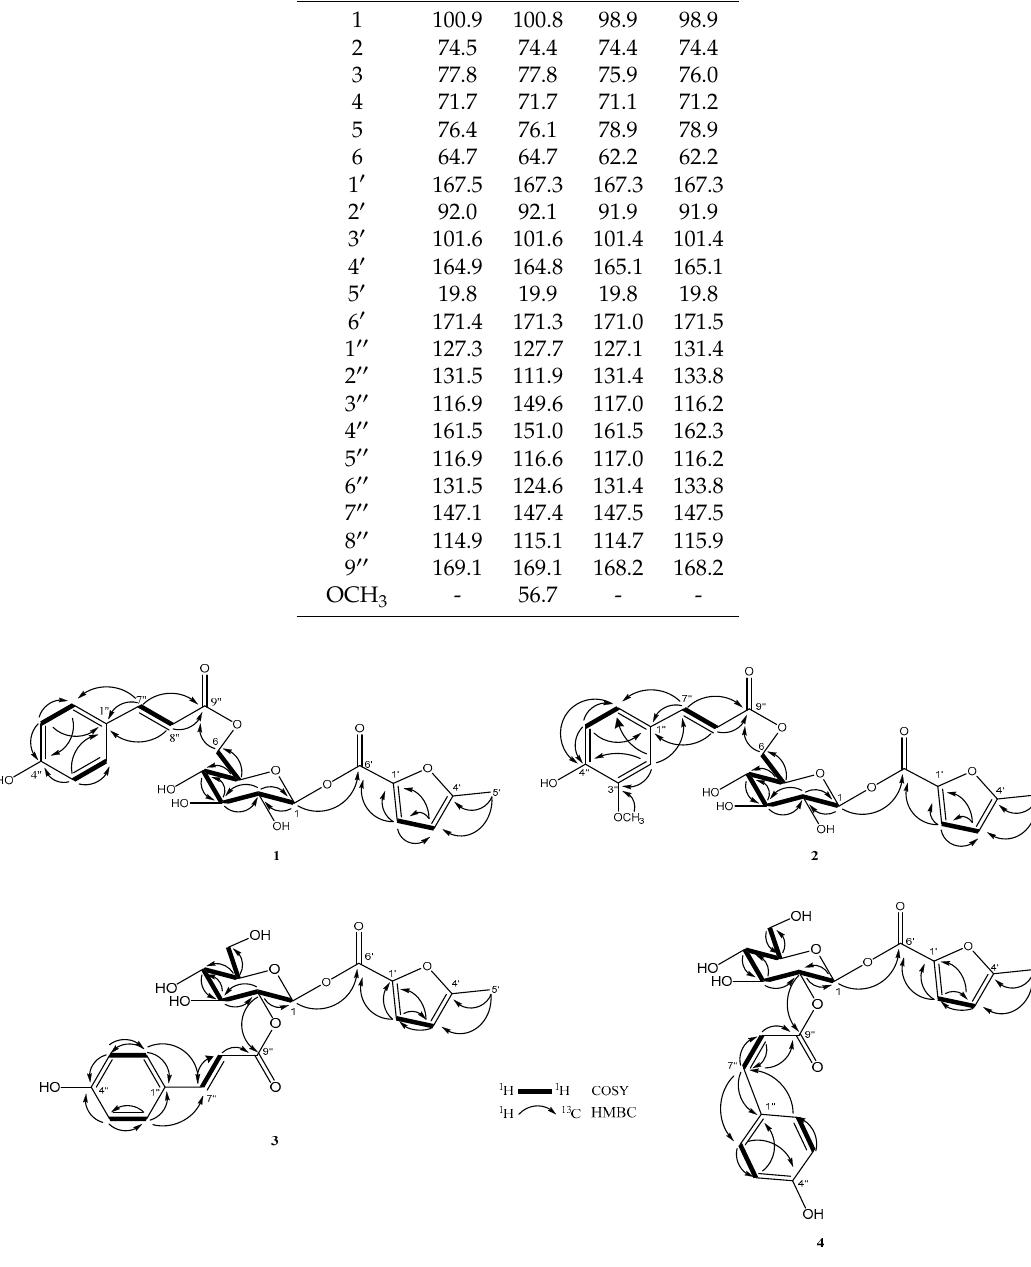
Figure 4. Key 1 H- 1 H COSY and HMBC correlations of compounds 1 – 4 .